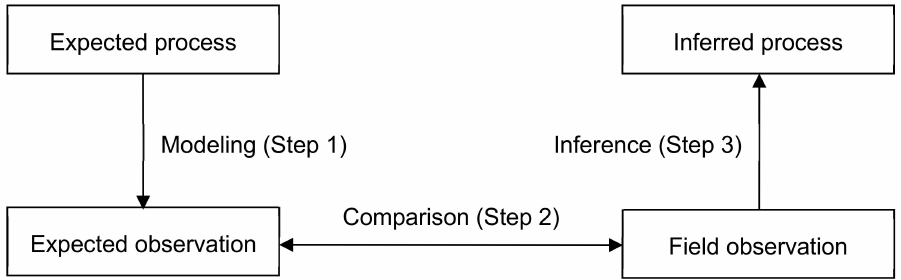
Figure 1. Diagram of inferring tra ffi c-induced processes from field observations.